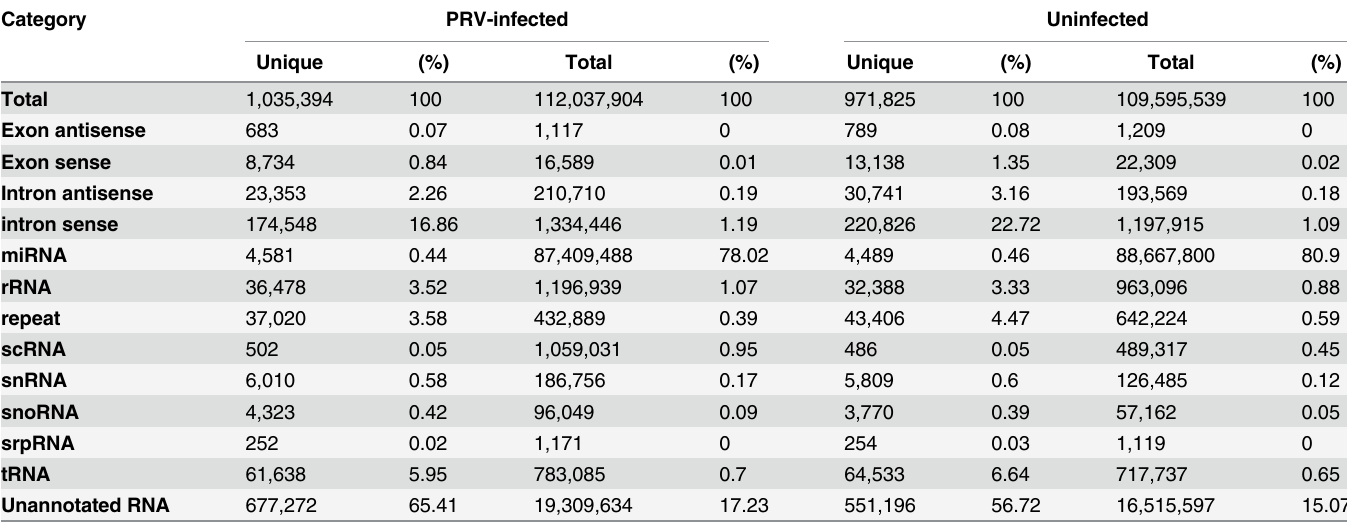
To validate the deep sequencing results, stem-loop RT-qPCR was used to verify the expression of virally encoded candidate miRNAs. Among 25 mature viral miRNAs, 20 miRNAs expressed in PRV JS-2012-infected PK15 cells were detected using this approach, with the exception of prv-miR-1, 6, 16, 21 and 25 (Fig 2). Stem-loop RT-qPCR was also used to confirm the differen- tially expressed host miRNAs. Eight differentially expressed miRNAs were analyzed (Fig 3). Table 1. Distribution of sRNAs in PRV-infected and uninfected